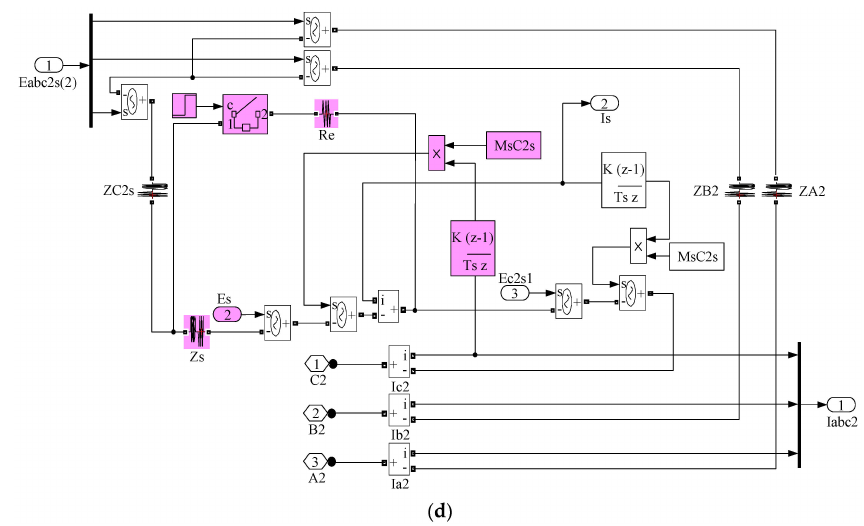
Figure 9. The simulation models of an ISCF in the DRPMSM: ( a ) The simulation model of the overall control system for the motor; ( b ) The sub-model of the vector control system; ( c ) The sub-model of the DRPMSM; ( d ) The sub-model of the set of faulty windings.